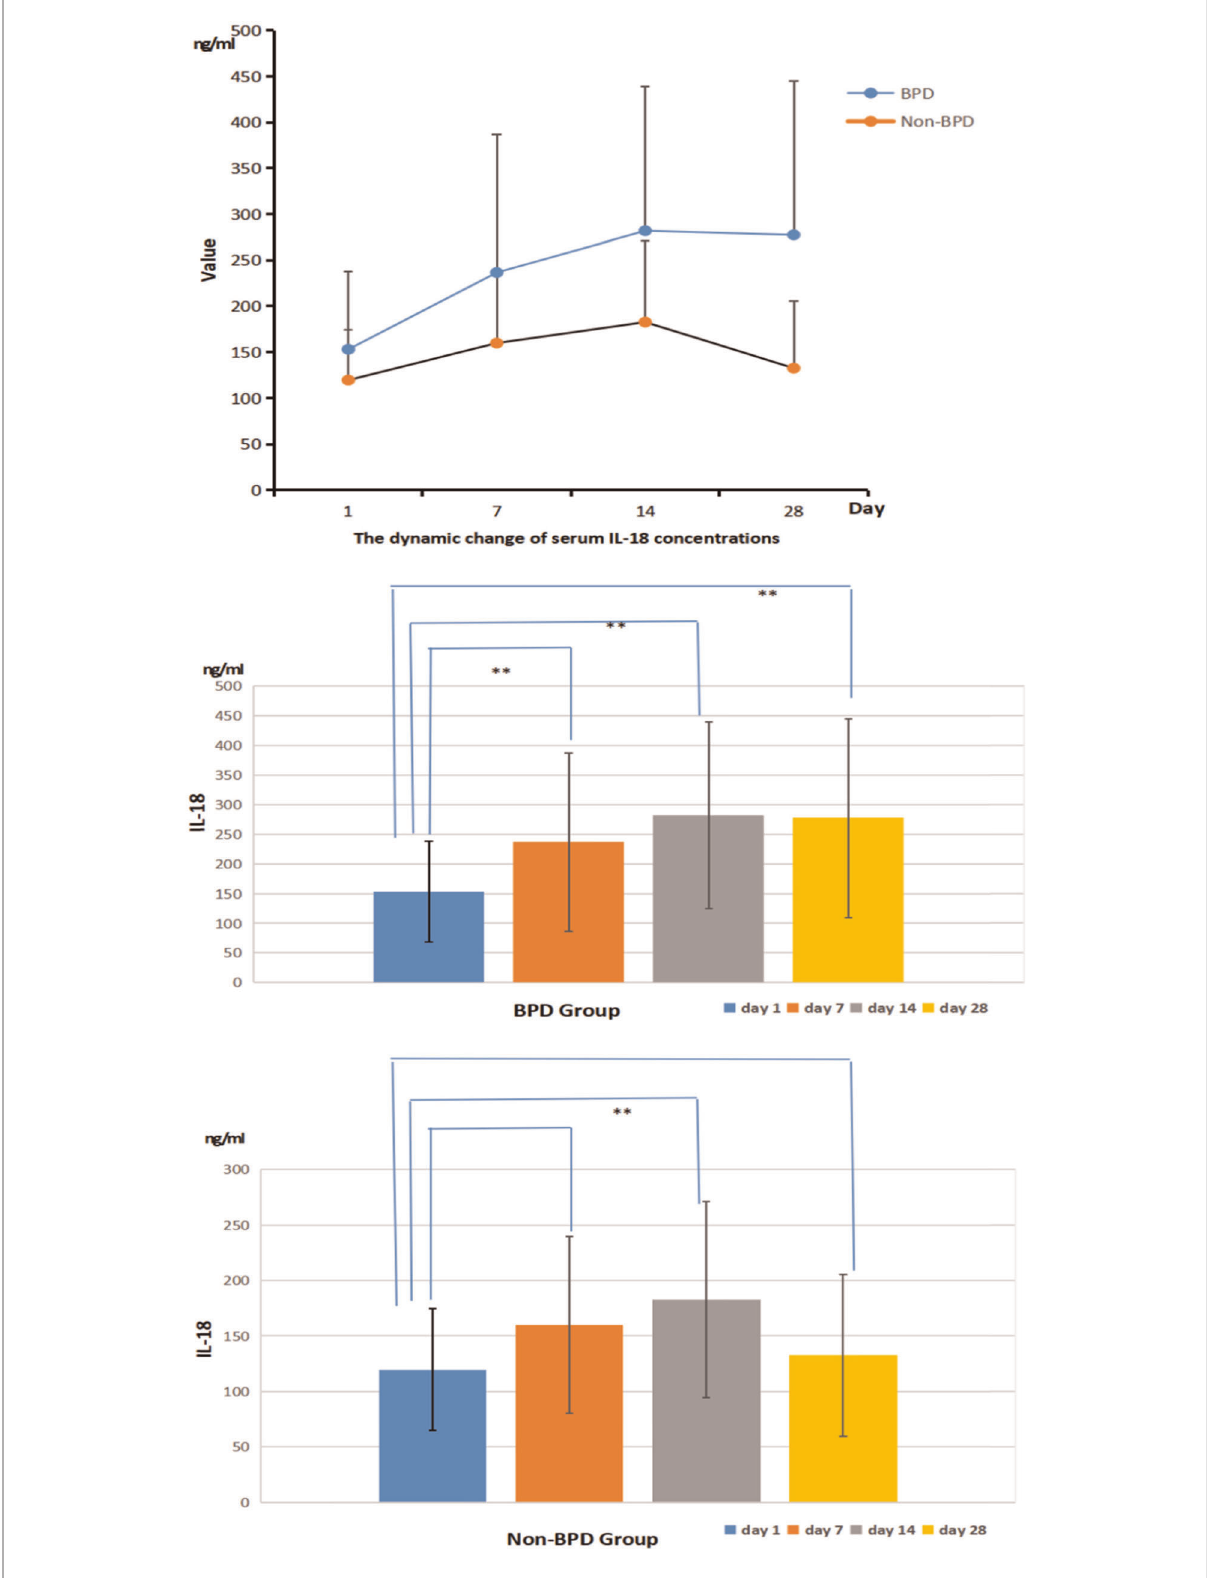
FIGURE 4 The dynamic serum IL-18 concentrations in the BPD and non-BPD group